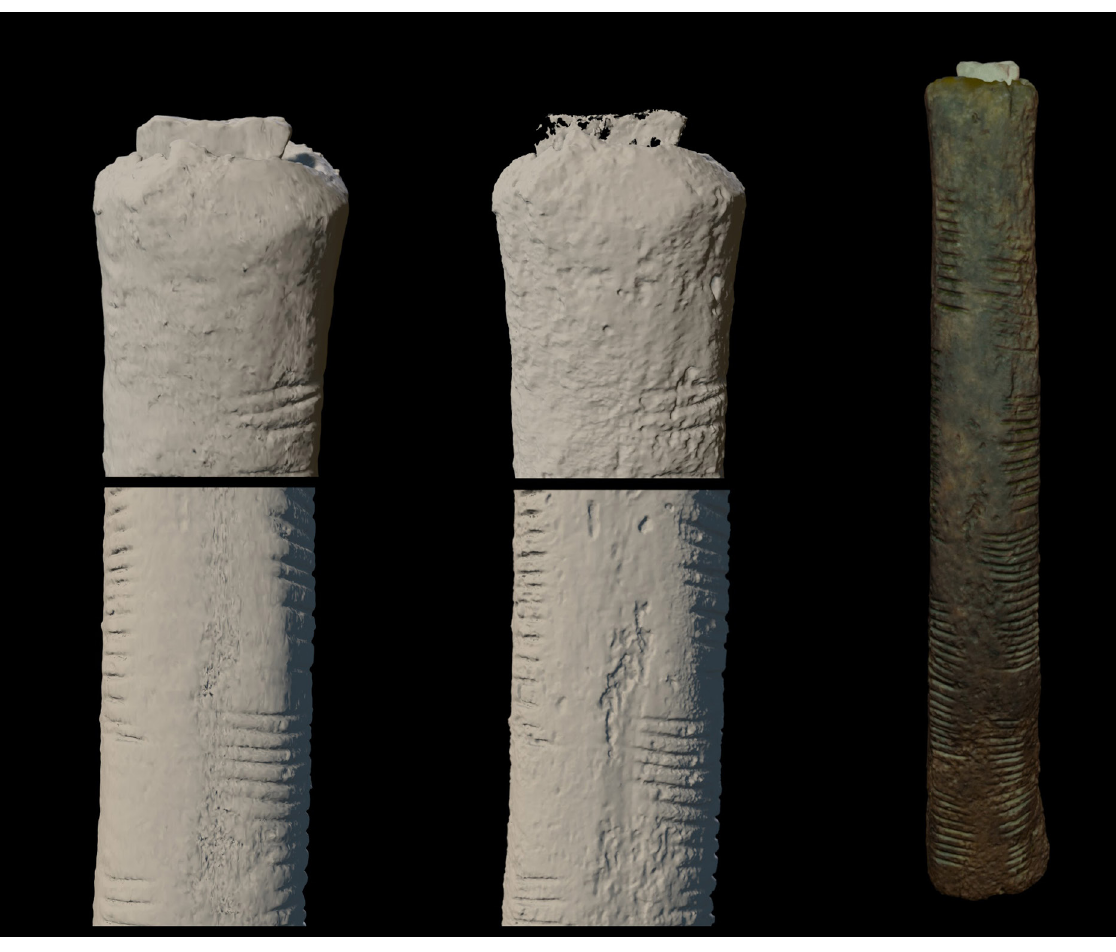
Fig. 6.14. Ishango rod. The left 3D model was acquired with a µCT many years ago. The middle one is scanned with the MechScan structured light scanner. The right one is the combination of both the µCT scan, the structured light scan and the texture of the photogrammetry